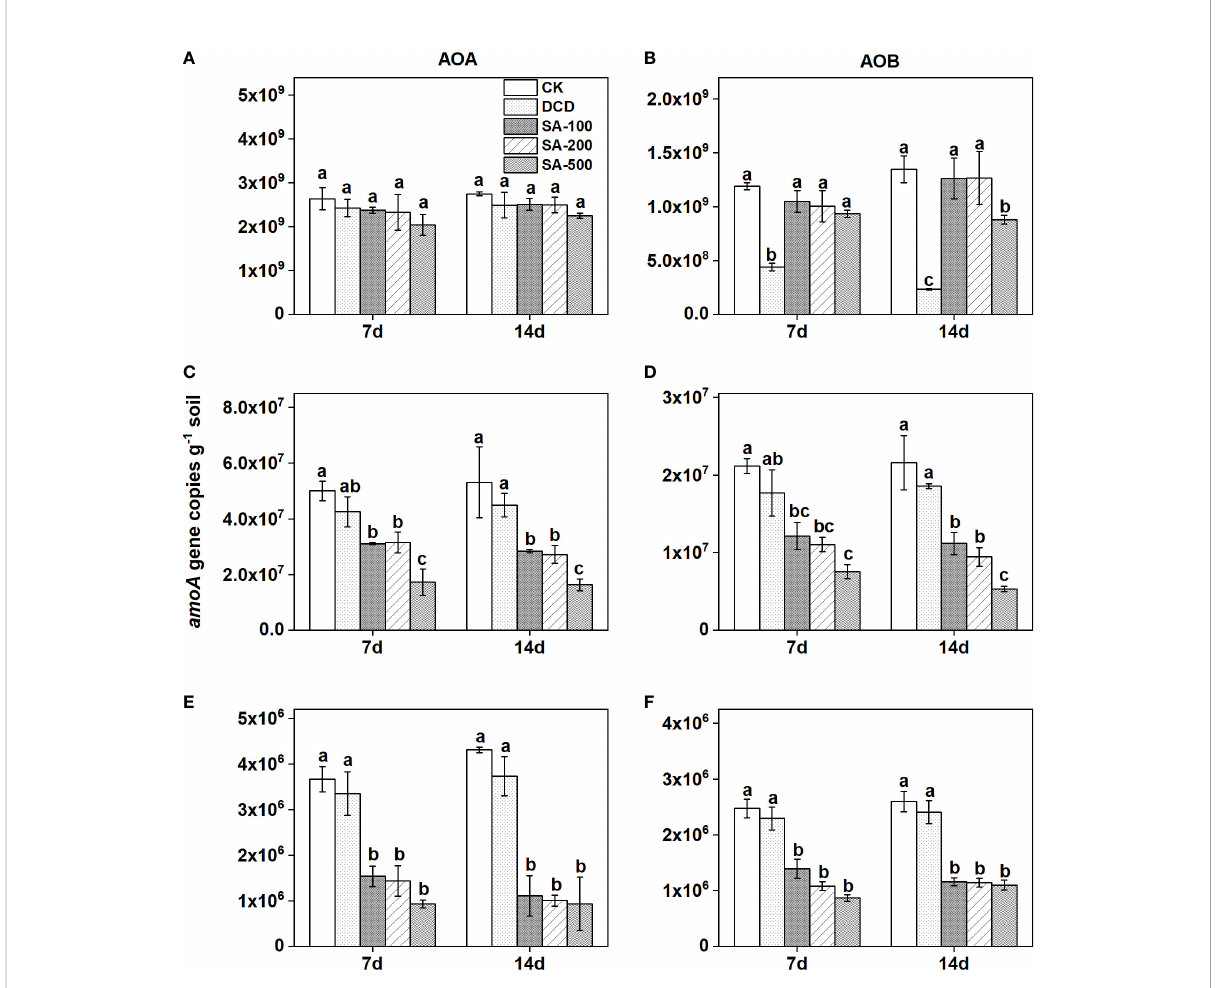
FIGURE 4 The amoA gene copy numbers of ammonia-oxidizing archaea (AOA) and bacteria (AOB) in calcareous soil (A, B) , paddy soil (C, D) , and red soil (E, F) under different treatments at day 7 and day 14 days. Values are means ± SE (n=3). Different letters indicate signi fi cant differences at P < 0.05 (LSD test) among